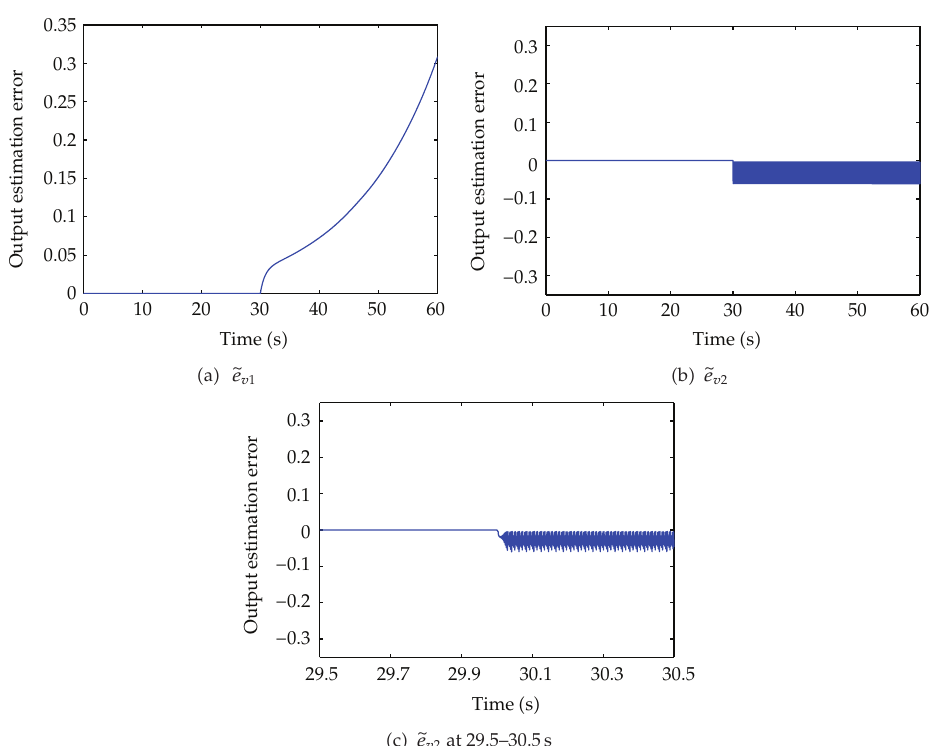
Figure 2: Output estimation error in case 1 using a low frequency